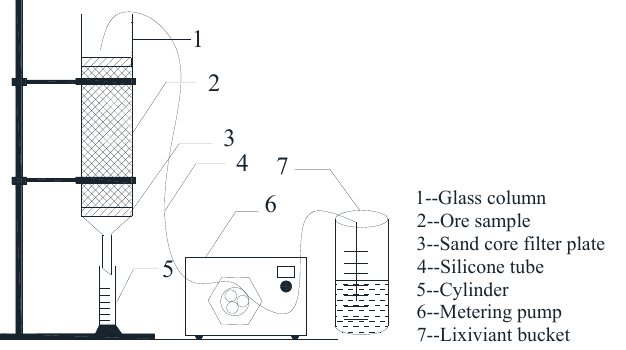
Figure 2. Schematic drawing of device used for leaching tests.